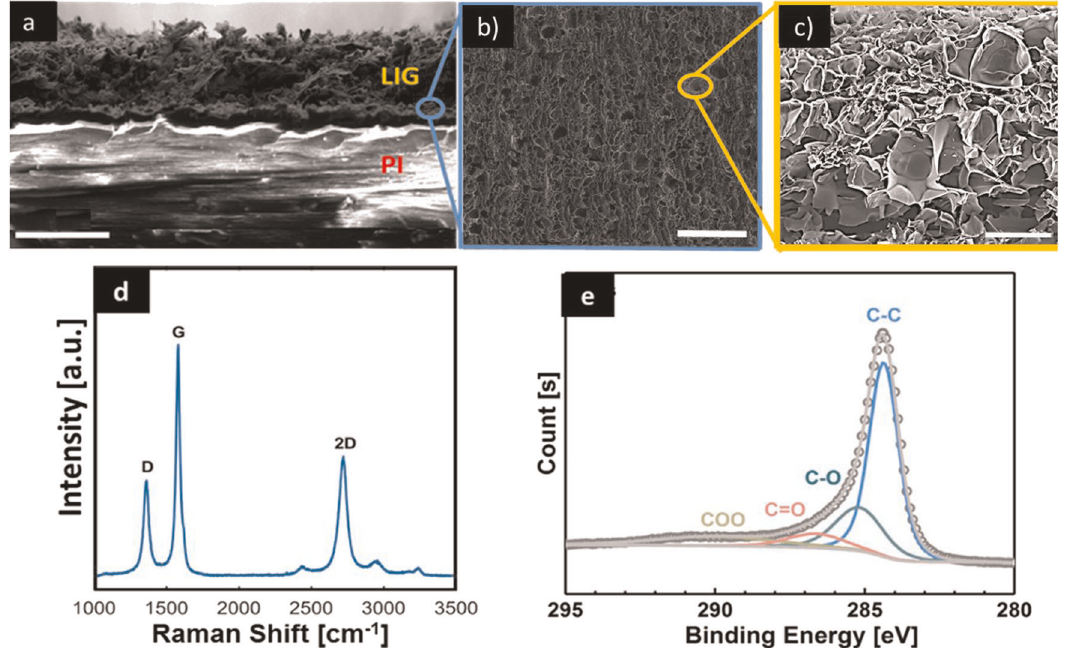
Fig. 1 a Cross-sectional SEM image of the porous carbon network lying on the top of polyimide (scale bar: 30 μ m). b Low-magni fi cation SEM image shows the porous morphology of LIG (scale bar: 15 μ m). c High-magni fi cation SEM image shows the graphene fl akes randomly arranged and interconnected (scale bar: 5 μ m). d Raman spectrum of LIG acquired with a laser wavelength of 473 nm. e High-resolution XPS spectrum of the C1s region of